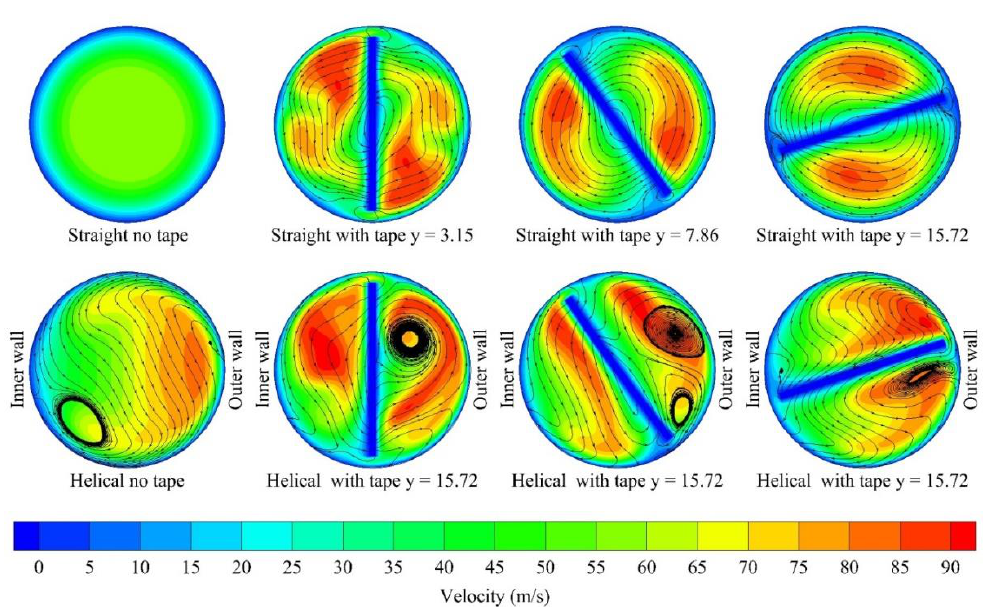
Figure 2. Velocity profile (contour, m/s) and streamlines of reactant flow in straight and helical reactors with various twisted tape insert configurations at L = 25.16 mm and Reynolds number of 1000.